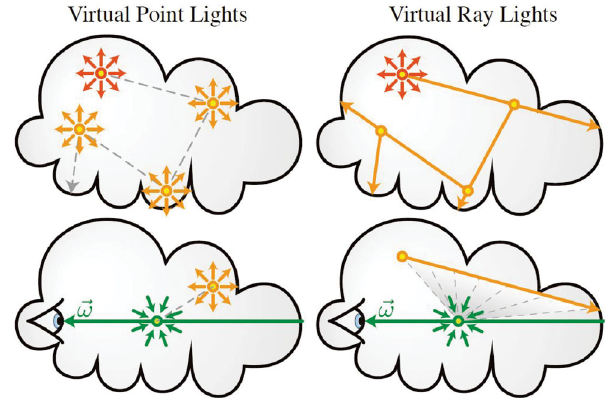
Fig. 6 Virtual point light methods (left) convert the vertices of a random-walk pre-process into a collection of virtual point lights (VPLs). Virtual ray lights (right) convert entire segments of the random-walk into virtual ray lights instead. This results in denser sampling, provably weaker singularities, and higher quality when estimating illumination from the collection of virtual lights (below). Reproduced with permission from Ref. [2], c (cid:2) ACM